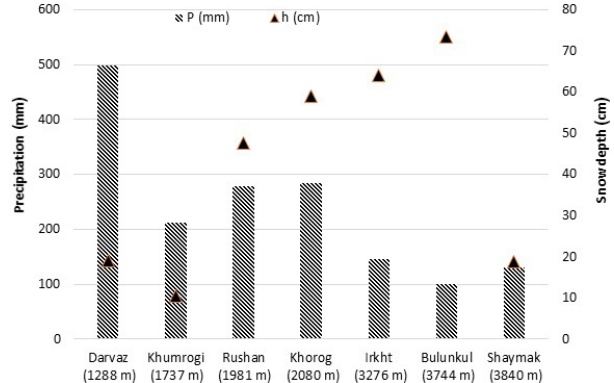
Figure 5. Average annual precipitation and snow depth for seven meteorologica stations in the Pyanj River Basin depending on alti- tude for the period 1944–2014.